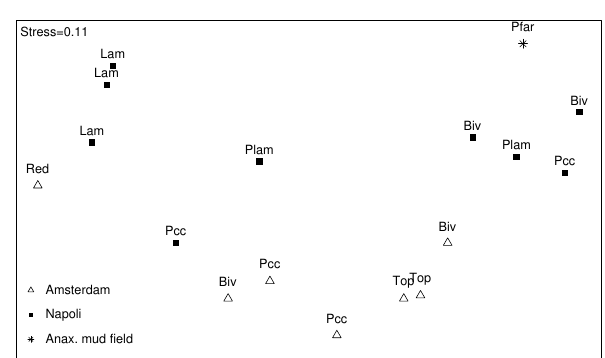
Fig. 5. Non-metric multidimensional scaling (nMDS) based on Bray–Curtis similarity of square root transformed nematode species data (Biv: bivalve shells; Pcc: periphery of carbonate crusts; Red: reduced sediments; Top: summit of the mud volcano; Lam: Lamel- librachia microhabitat; Plam: periphery of Lamellibrachia ; Pfar: far